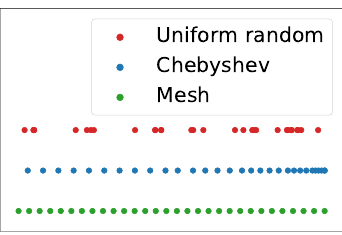
Figure 3. Three different observation sampling methods for 30 of 100 hypothetical observations. The vertical axis is only meant to separate the different spacing